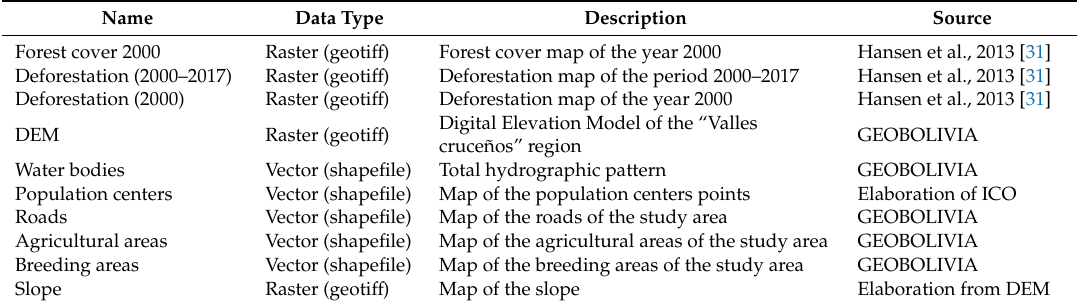
Table 1. Description of data collected and processed for the study